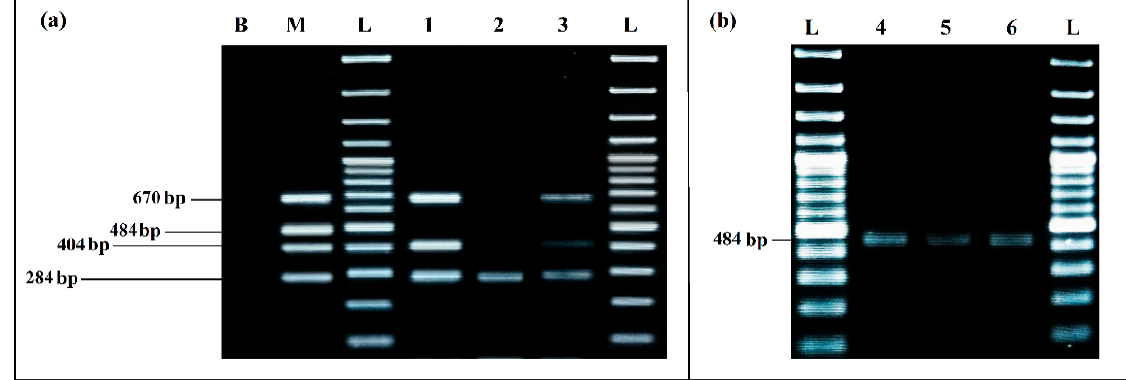
Figure 8. PCR detection from food matrices artificially inoculated and enriched in BPW: ( a ) mPCR. B, negative control; M, positive control; L, 100 bp DNA ladder; lane 1, mPCR results from lettuce artificially inoculated (10 3 CFU/mL); lane 2, mPCR results from minced meat artificially inoculated (10 3 CFU/mL); lane 3, mPCR results from minced meat artificially inoculated (10 3 CFU/mL); L, 100 bp DNA ladder. ( b ) Simplex PCR for S. aureus ; L, 100 bp DNA ladder; lane 4, PCR results from lettuce artificially inoculated (10 3 CFU/mL); lane 5, PCR results from minced meat artificially inoculated (10 3 CFU/mL) before incubation; lane 6, PCR results from minced meat artificially inoculated (10 3 CFU/mL) after incubation; L, 100 bp DNA